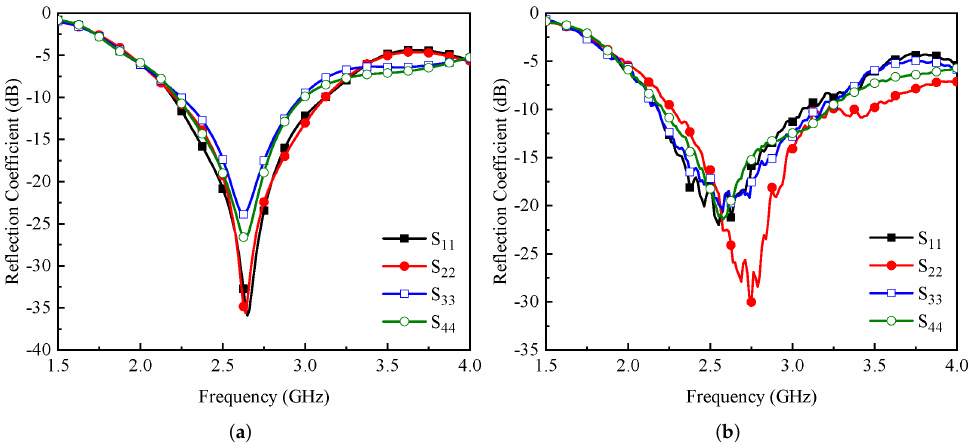
Figure 5. ( a ) Simulated and ( b ) measured reflection coefficients of the MIMO antenna